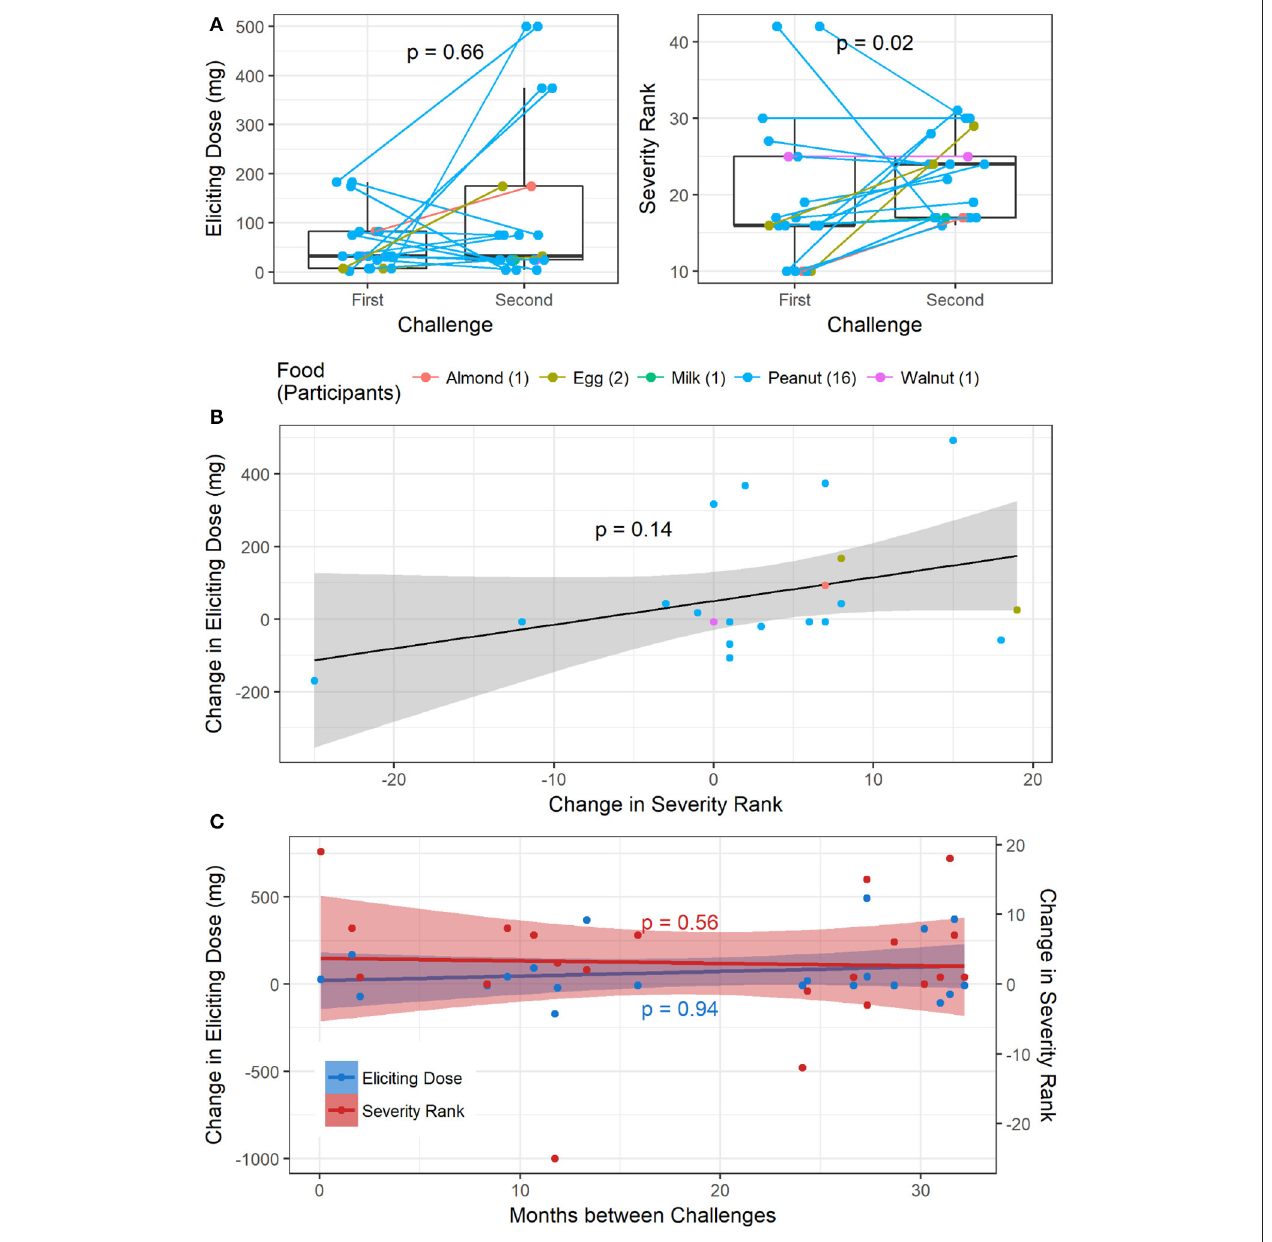
FIGURE 6 | Repeat challenges: (A) boxplot of change in ED and severity ranking from first to second challenge. (B) Association between change in ED and change in severity ranking. (C) Association between change in ED and time between challenges, and change in severity and time between